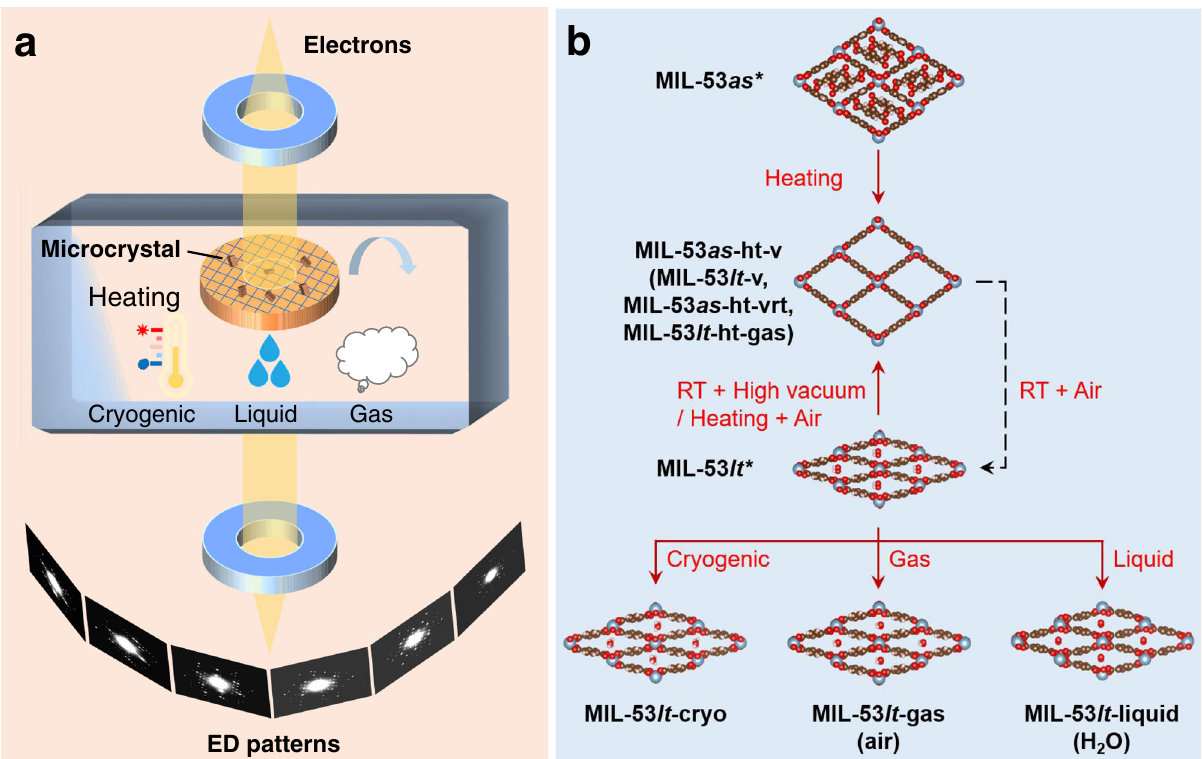
Fig. 1 | Representation of environmental 3D electron diffraction and its appli- cation. a The crystals are placed into various environmental conditions, such as heating, cryogenic cooling (after plunge-freezing sample preparation), gas atmo- sphere and liquid environments, and 3D electron diffraction data are collected.